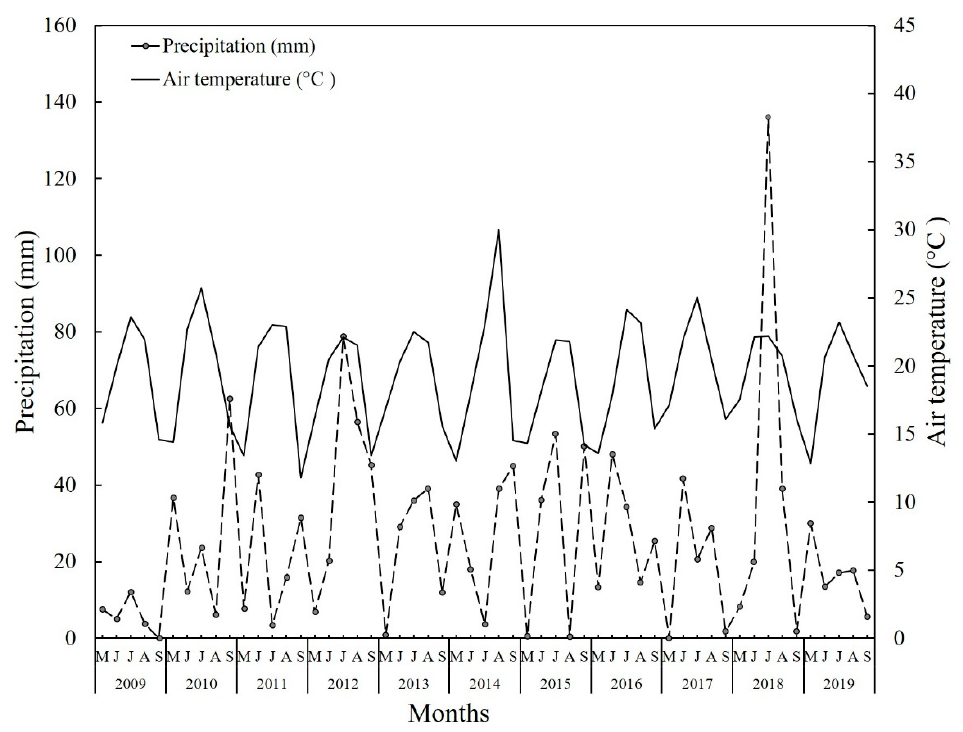
Figure 2. Mean monthly air temperature (solid line) and precipitation (broken, dotted line) in the experimental site during the growing season (i.e., May–September